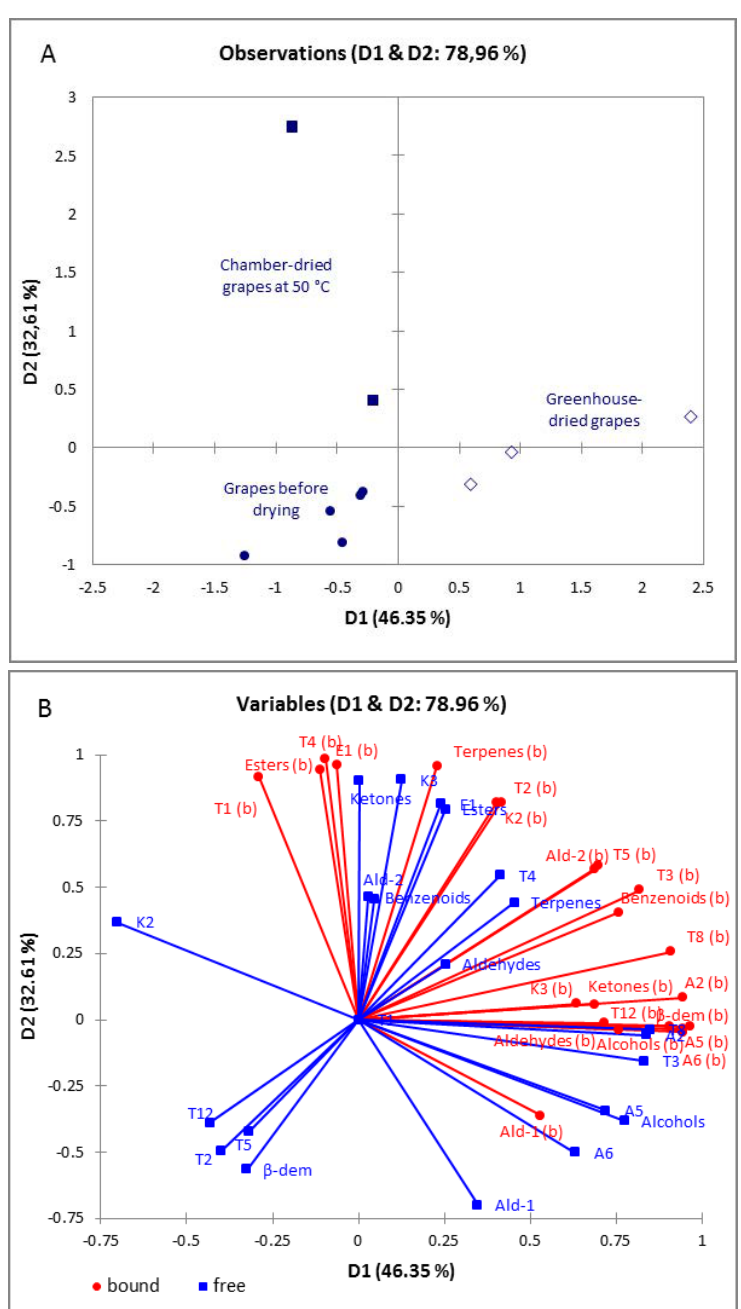
Figure 1. Principal component analysis of composition distribution of: ( A ) grapes (fresh or dried) and ( B ) their free and bound (b) volatile compounds.